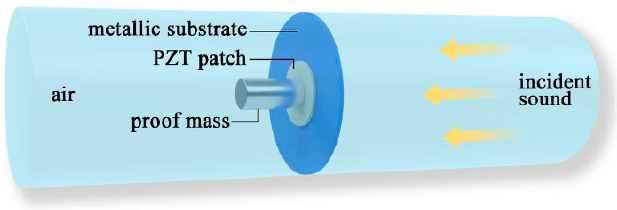
Figure 22. Schematic diagram of the proposed metamaterial structure for AEH [64].